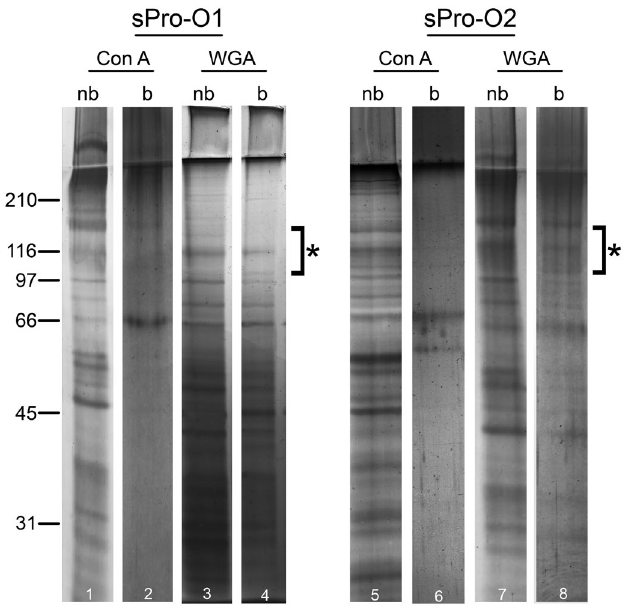
Figure 5. Protein composition of seminal prostasomes from oligozoospermic men separated by lectin-affinity chromatography. Seminal prostasomes sepa- rated by lectin-affinity chromatography were resolved on 10% SDS-PAGE under reducing and denaturing conditions and stained with silver. Representative total protein patterns of non-bound (nb) and bound (b) fractions separated on a Con A column and on a WGA column were shown. Samples were loaded as isolated (equal volume/line to reflect yield), and total protein amounts were: line 1 (19 l g), line 2 (10 l g), line 3 (14 l g), line 4 (11 l g), line 5 (50 l g), line 6 (6 l g), line 7 (24 l g), line 8 (13 l g). Characteristic prostasome-associated bands in the region of 90 – 150kDa are marked (asterisk). Numbers indicate the pos-